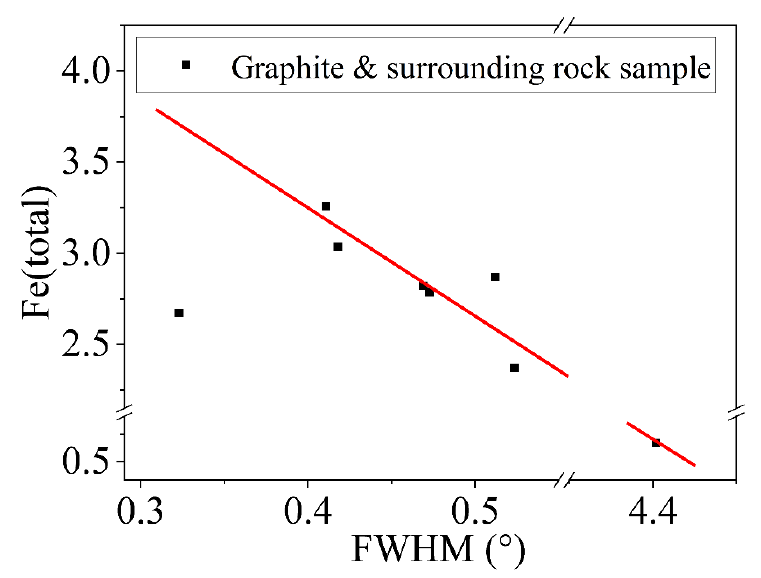
Figure 8. Relationships between the value of total Fe 2+ of chlorite and the FWHM (d002) of graphite XRD spectra.